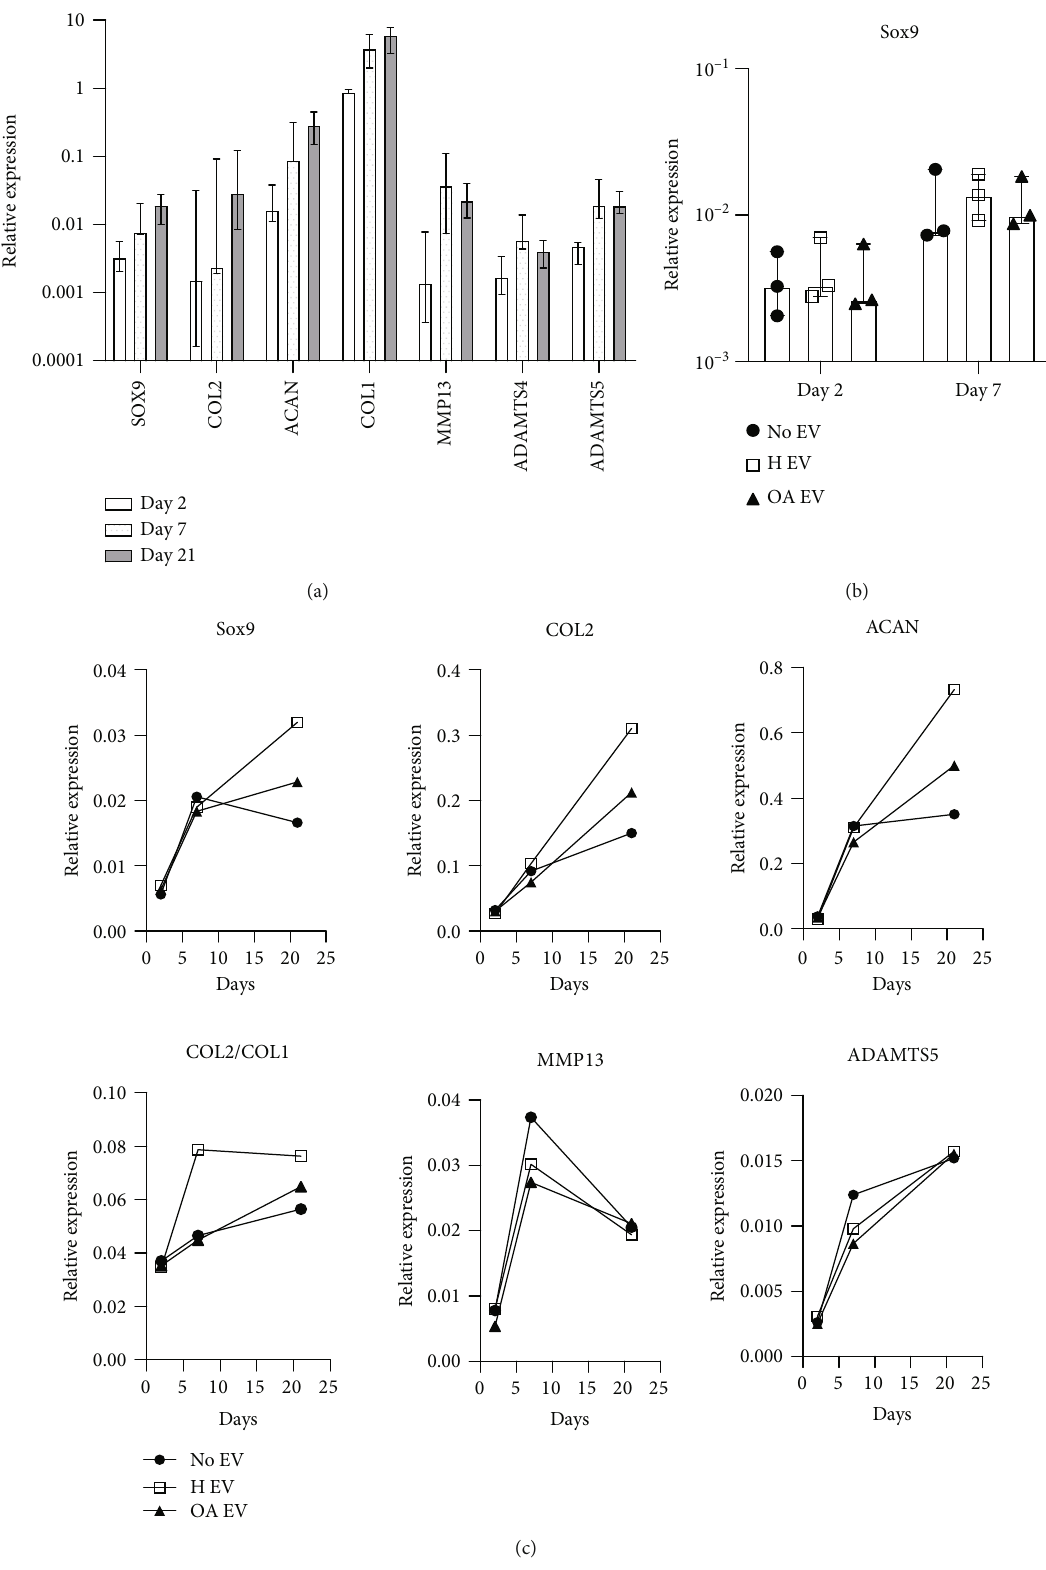
Figure 3: Gene expression of characteristic cartilage catabolic and anabolic genes measured in (a) untreated chondrocytes (no EVs) cultured for 2, 7, and 21 days. Horizontal bars show medians, and whiskers represent interquartile range. (b) SOX9 expression in untreated and H-EV or OA-EV treated chondrocytes after 2 and 7 days. Symbols represent individual donor-derived chondrocyte cultures. (c) Chondrogenic gene expression in untreated (no EVs) and treated (H-EVs and OA-EVs) chondrocytes after 2, 7, and 21